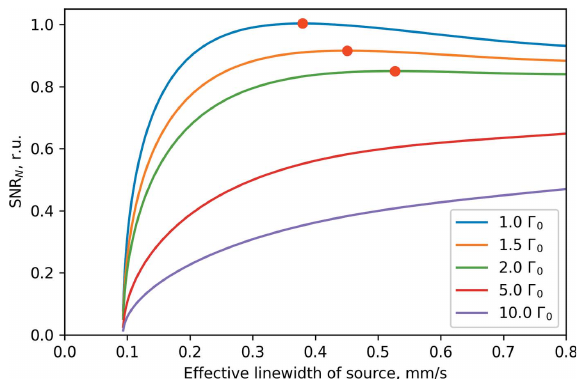
Figure 7 Estimated normalized signal-to-noise ratio (SNR N ) for indicated intrinsic spectrum widths. Estimation was made using the envelope (blue dashed line) from Fig. 5. Red dots indicate